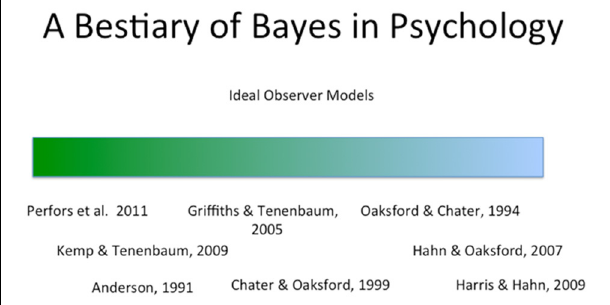
FIGURE 1 | The figure presents examples of applications of Bayesian modeling. The examples, discussed in the text, reflect both different types of application in terms of the aspect of the cognitive system modeled, and the theoretical and methodological role accorded to Bayesian inference as a